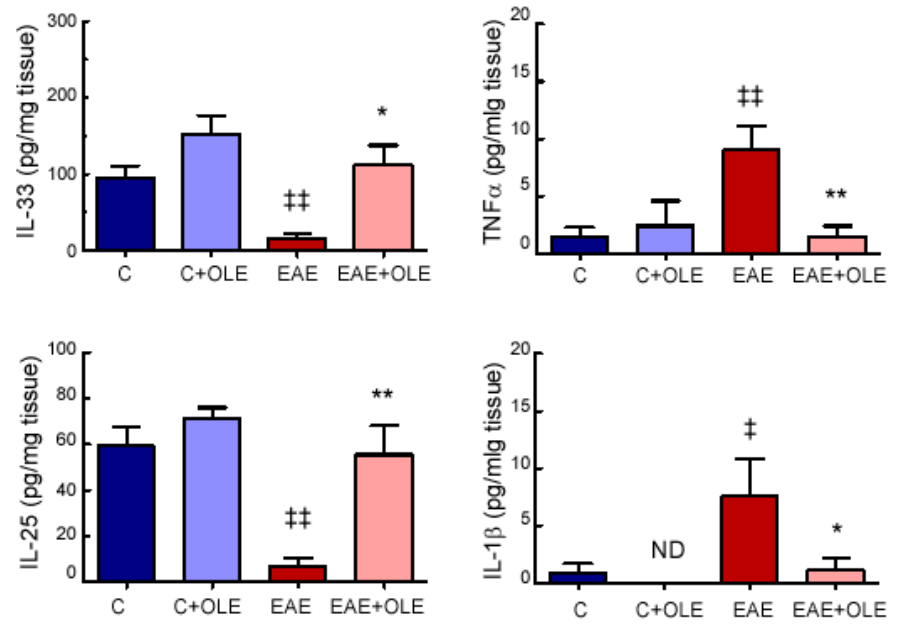
Figure 4. OLE treatment modulates inflammatory parameters in colon tissue from EAE mice. Levels in colon of the inflammatory mediators IL-33, TNF α , IL-25 and IL-1 β were quantified by ELISAs. Bar graphs represent the mean ± SEM of 5–7 animals. ‡ p < 0.05 and ‡‡ p < 0.01 vs. control; and * p < 0.05 and ** p < 0.01 vs. untreated-EAE. C, healthy mice. C + OLE, healthy mice treated with OLE. EAE, induced mice. EAE + OLE, induced mice treated with OLE.